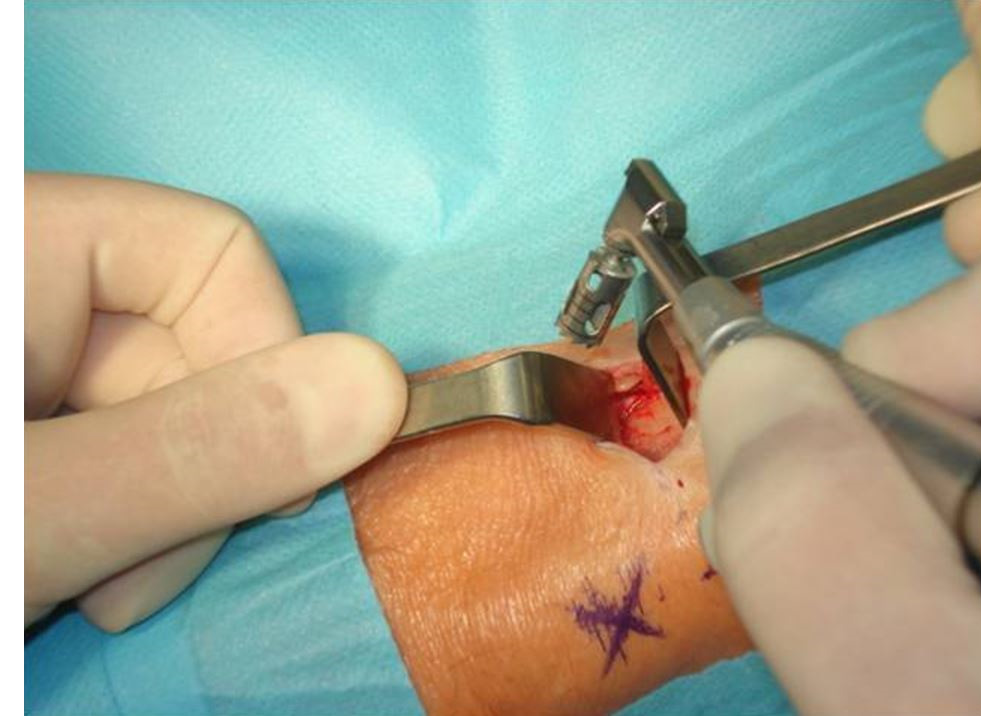
Figure 2. An opening in the cortical layer is made with a trephine bur 8 mm in diameter.